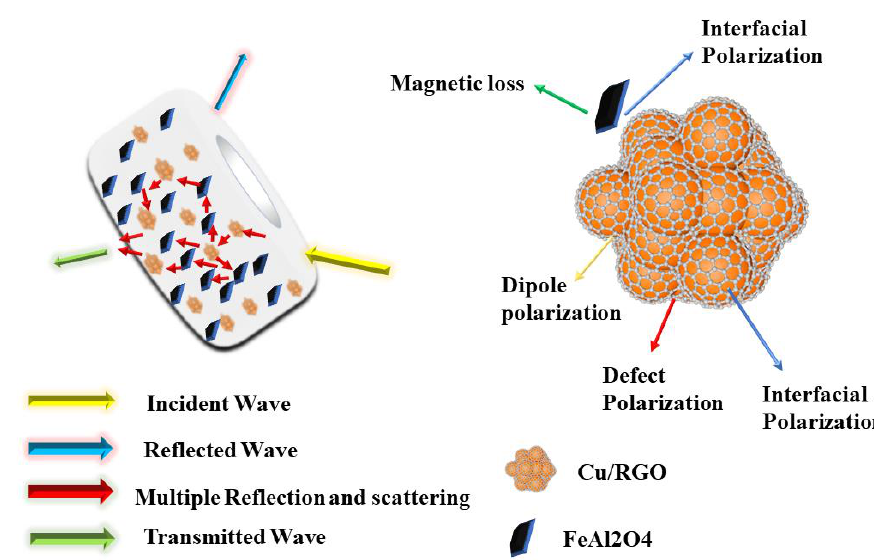
Figure 11. Schematic of microwave absorption mechanisms of the FeAl 2 O 4 /Cu/RGO.